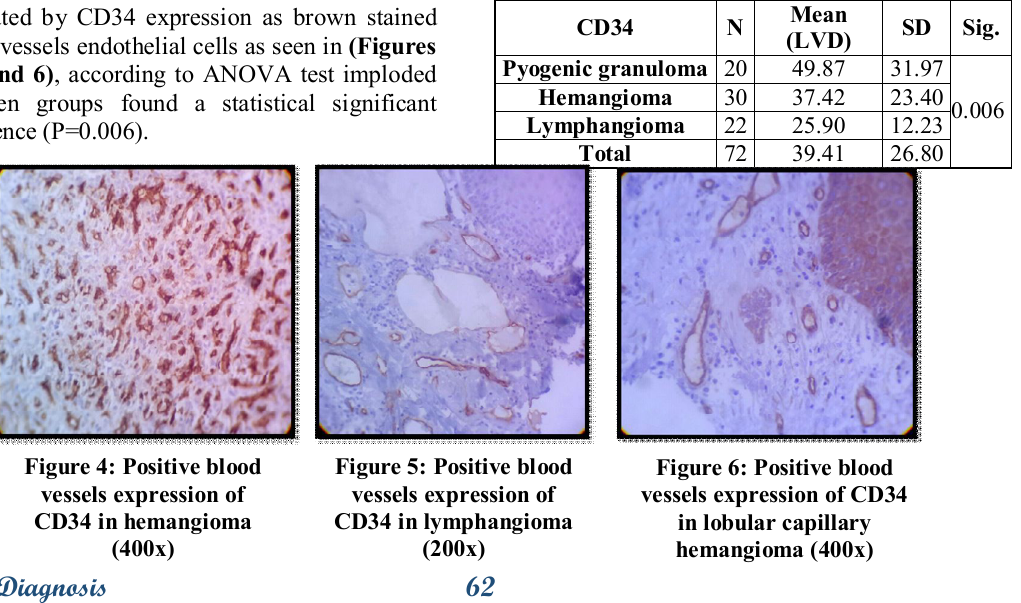
Figure 2: Positive Figure 3: Positive lymphatic endothelium lymphatic endothelium expression of D2-40 in expression of D2-40 in lymphangioma (400x) lobular capillary hemangioma (400x). Table 2: Description of statistics obtained by